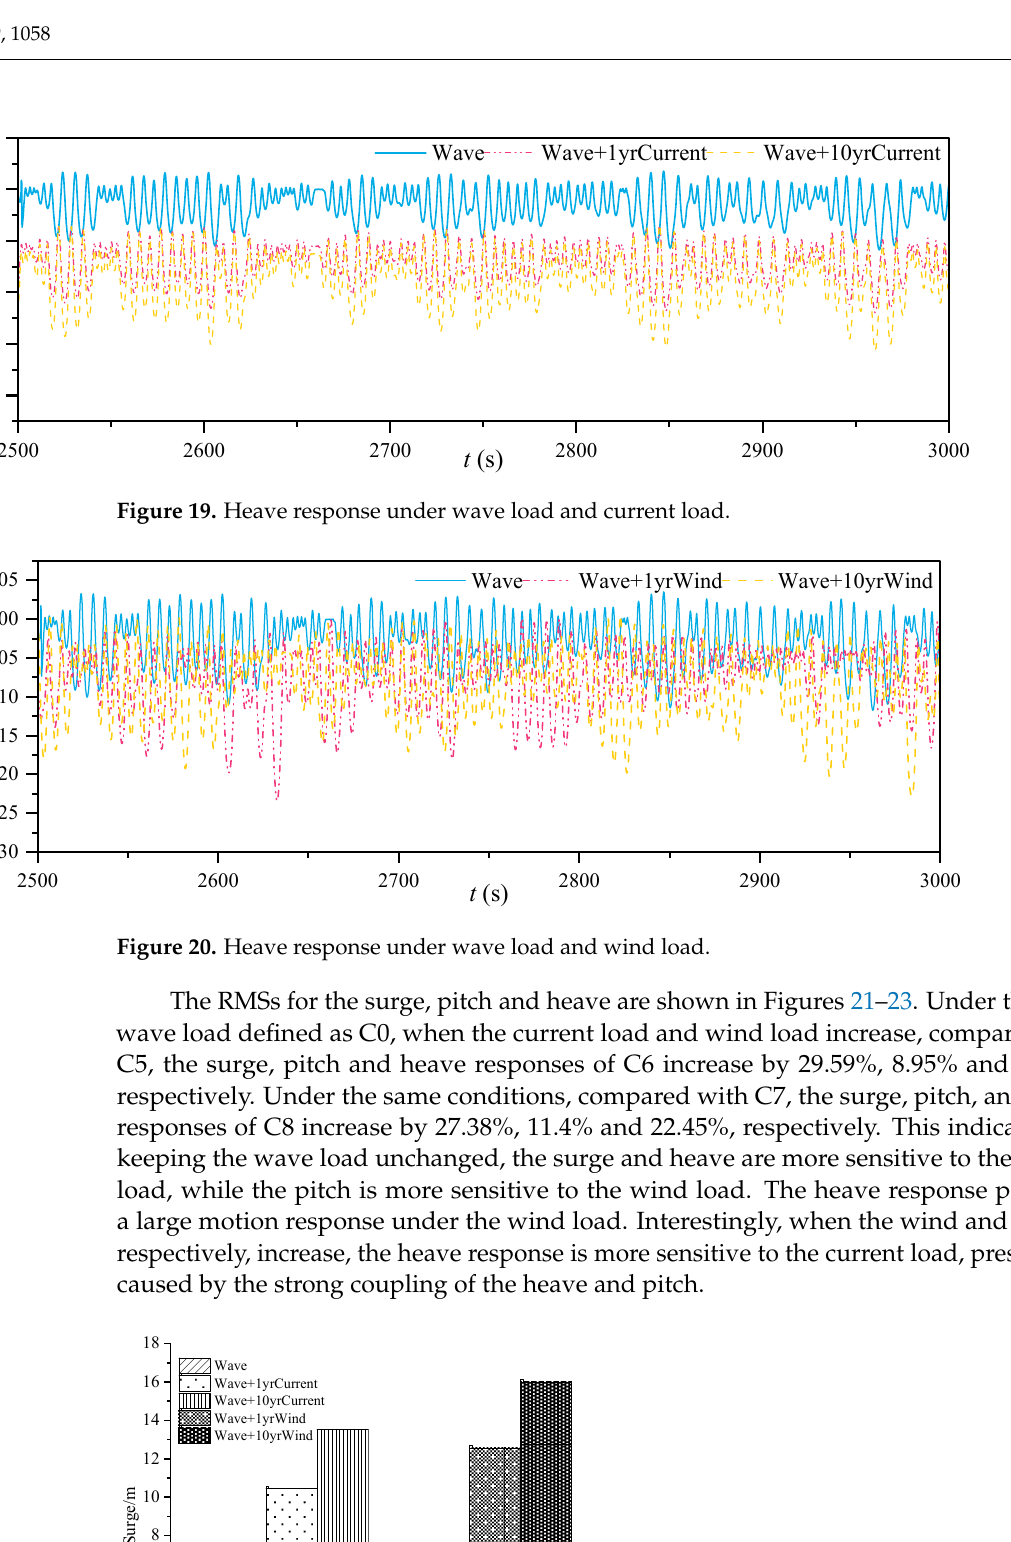
Figure 22. RMS for pitch responses. Figure 23. RMS for heave responses. 4.4. Variation in Tendon Tension Due to the symmetry of the typical ISSC TLP, when the wind, wave and current act together at 45°, the tension of the tendons is similar in pairs. This section selects the in- clined tension legs L2, L4, L6 and L8 as the analysis objects. As seen from Figures 24 and 25, when the angle is 0°, it shows minor variation in the tension range.